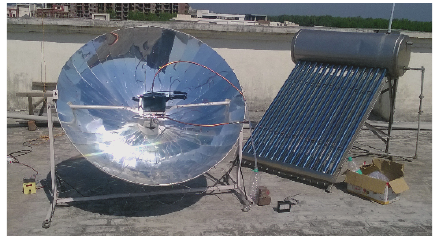
Figure 2: Experimental setup of high rated solar distilled